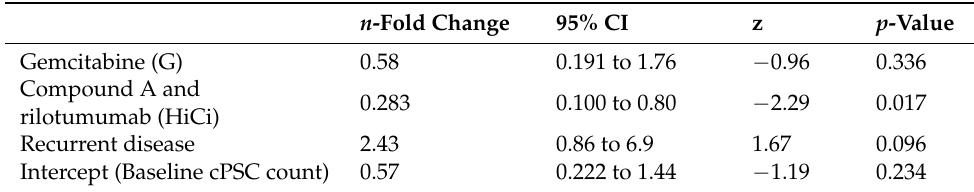
Table A8. Model specification for Figure 4e: Poisson regression model of portal vein cPSC counts versus treatments. This model assesses the effects of treatments on cPSC counts, taking into account the tumour burden at the end of the experiment (as measured by bioluminescence flux). Note: The interaction term was dropped as it was not statistically